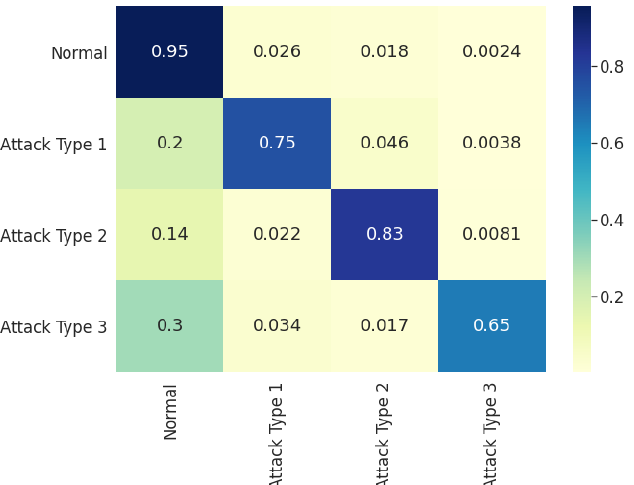
Figure 6. Confusion matrix on the experiment result.